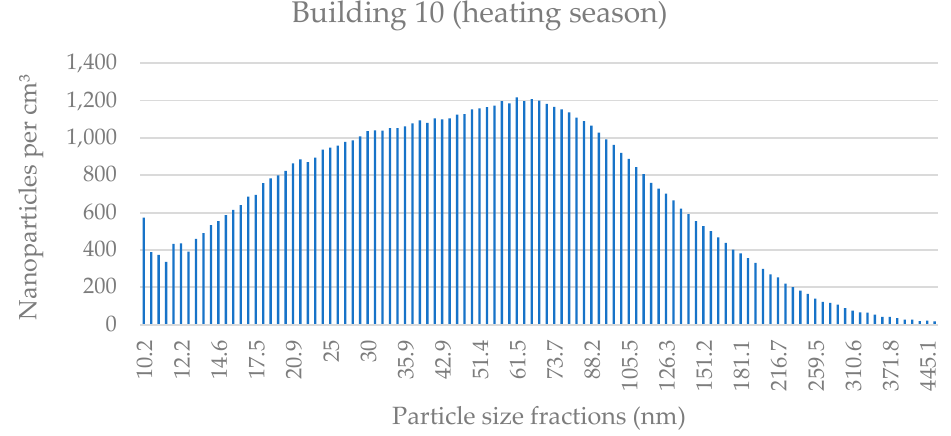
Figure A20. The average nanoparticle concentration in each size fraction in Building 10 during a one-week measurement period during the nonheating season. Figure A21. The average nanoparticle concentration in each size fraction in Building 11 during a one-week measurement period during the heating season.